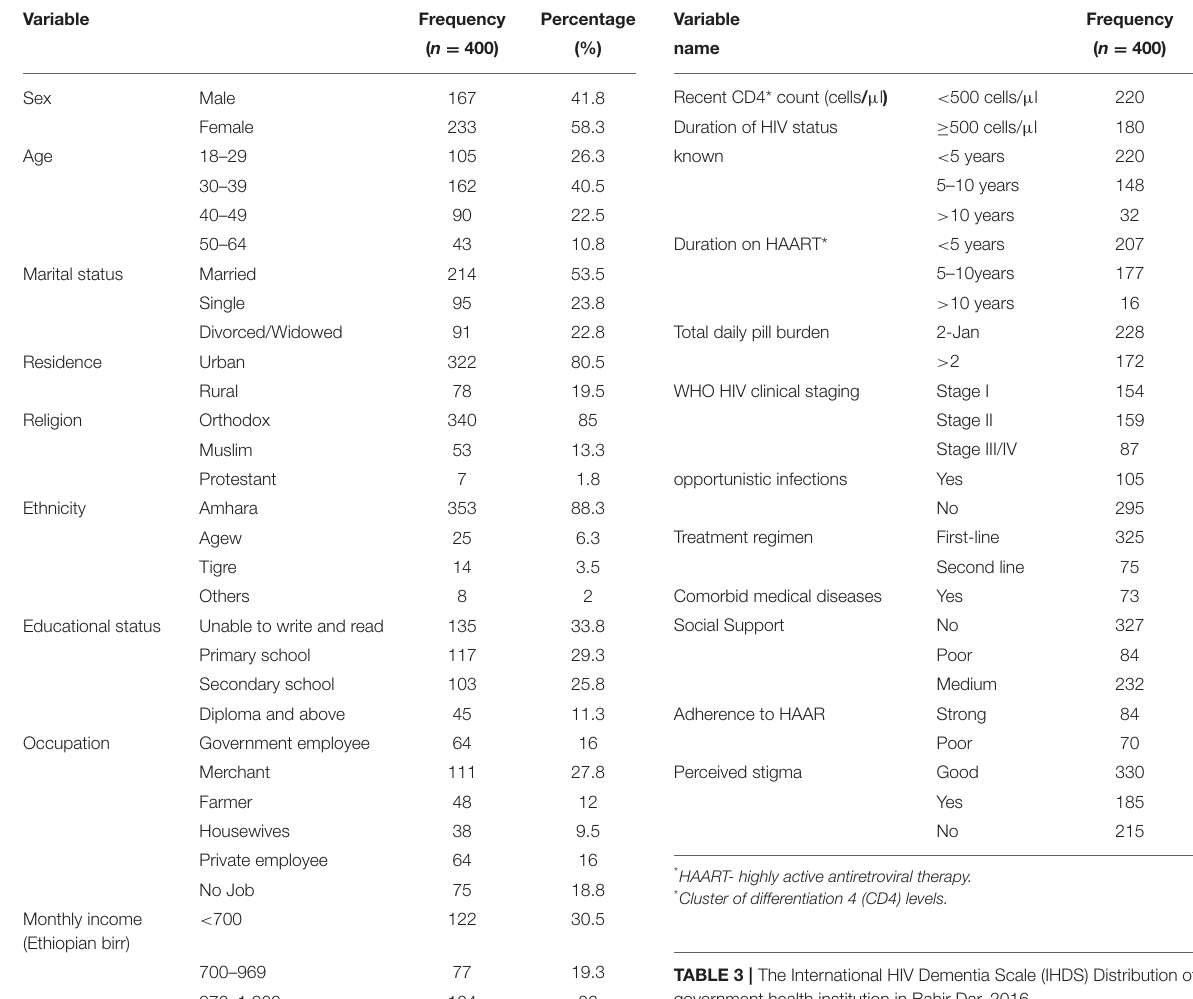
TABLE 1 | Distribution of participants by socio-demographic characteristics of the government health institution in Bahir Dar, 2016. Variable